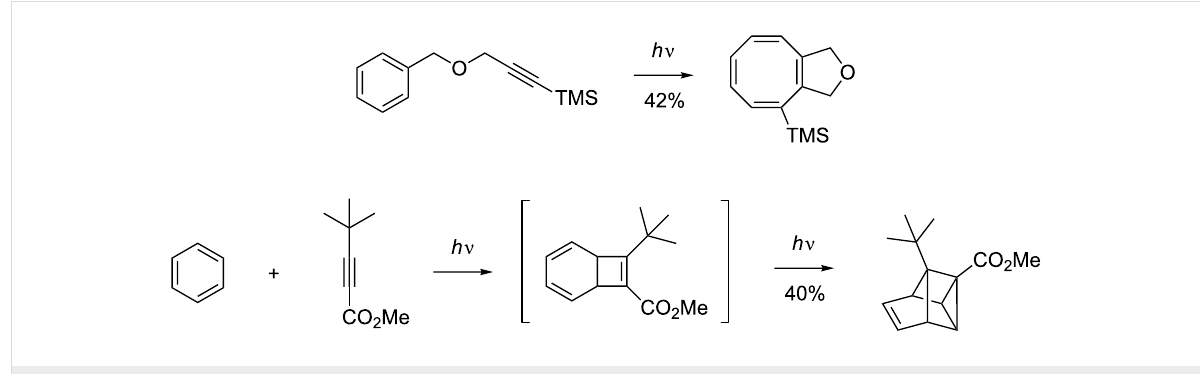
Scheme 27: Ortho photocycloadditions with alkynes.